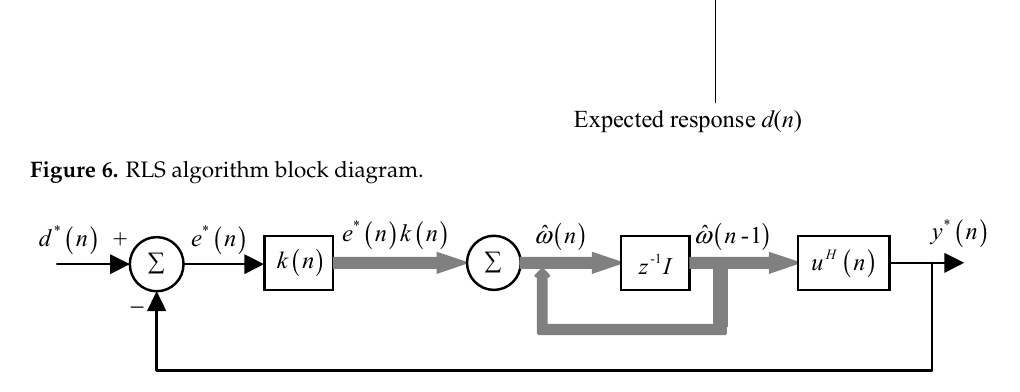
Figure 7. RLS signal flow diagram.